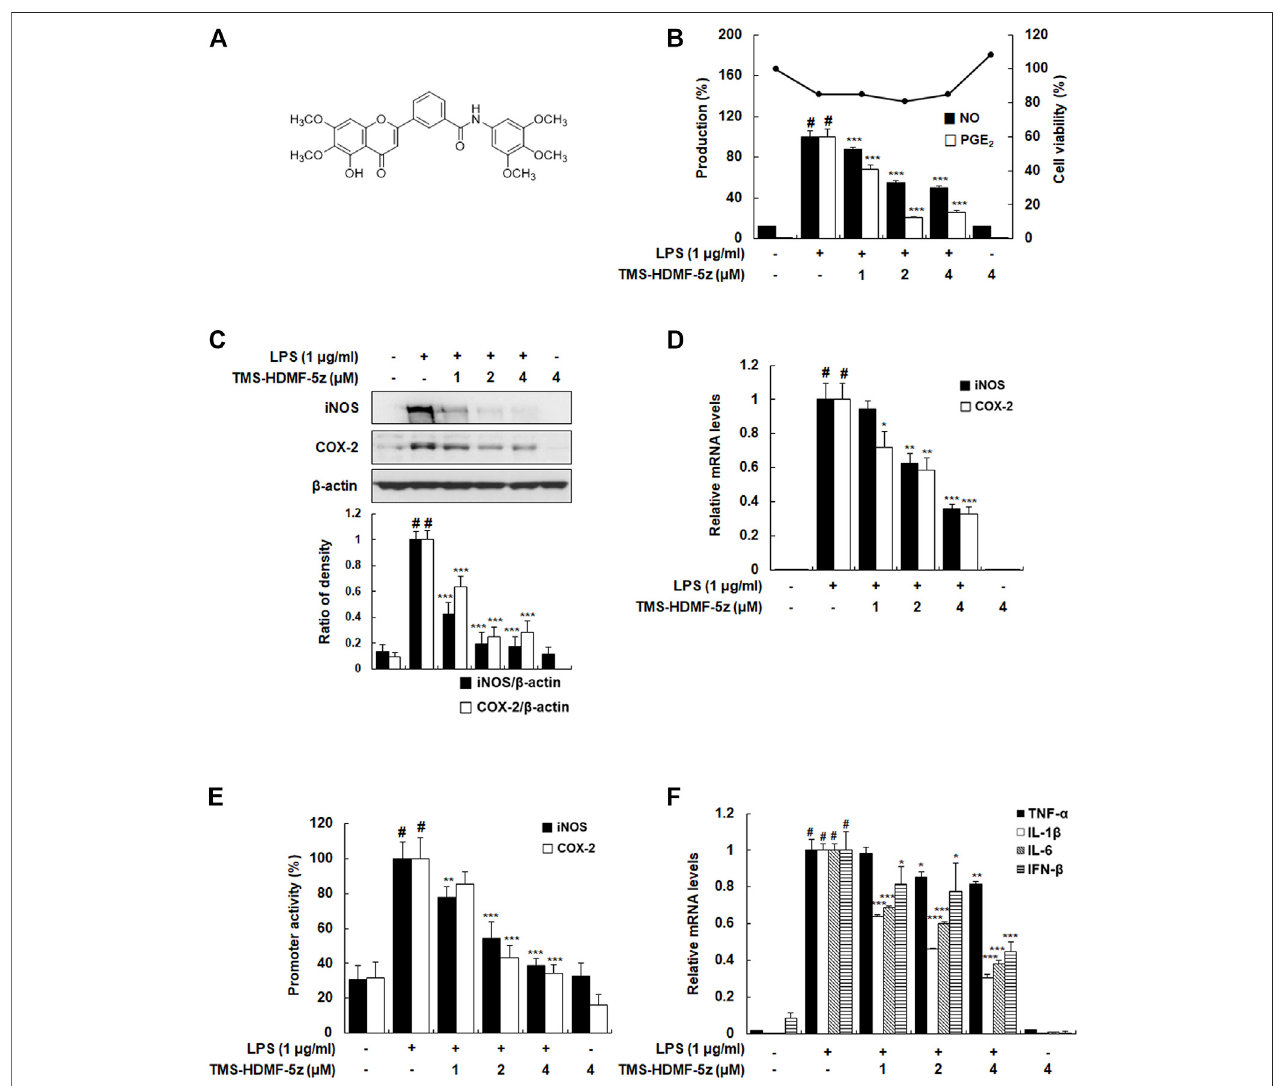
FIGURE 1 | Inhibitory effects of TMS-HDMF-5z on LPS-induced production of NO and PGE 2 , expression and promoter activities of iNOS and COX-2, and mRNA expression ofTNF- α , IL-1 β ,IL-6, and IFN- β in RAW 264.7macrophages. (A) Chemical structure ofTMS-HDMF-5z. (B) NO and PGE 2 production wasdeterminedusing theGriessreactionandanEIAkit(EnzoLifeSciences,Inc.,NY,UnitedStates), respectively.CellviabilitywasanalyzedbyMTTassay. (C) TheproteinexpressionofiNOS and COX-2 was detected by western blotting. The relative optical density ratio was determined using a densitometric analysis program (Bio-Rad Quantity One ® Software, version 4.6.3 (Basic), Bio-Rad Laboratories Inc., CA, United States), normalized to the internal control. (D) The mRNA levels of iNOS and COX-2 were quanti fi ed by qRT-PCR. The levels of iNOS and COX-2 were adjusted by ß -actin expression. (E) The promoter activities of iNOS and COX-2 were determined using luciferaseassaysystems. (F) ThemRNAlevelsofTNF- α ,IL-1 β ,IL-6,andIFN- β werequanti fi edbyqRT-PCR.Theexpression levelsofTNF- α ,IL-1 β ,IL-6,andIFN- β were adjusted by ß -actin expression. The values shown are the mean ± S.D. of three independent experiments. p < 0.05 vs . the control group, *p < 0.05, **p < 0.01, ***p < 0.001 vs . LPS-treated cells.